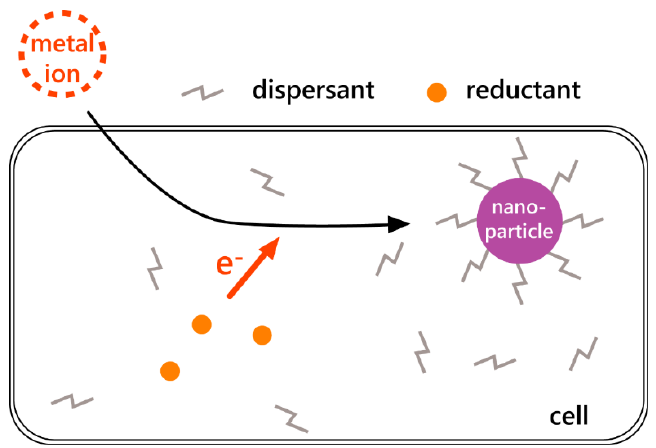
Figure 3. Model of metal nanoparticle synthesis inside cells. Metal ions are reduced by redox enzymes in the cytoplasm. The metabolites inside the cells surround the surface of NPs and behave as dispersants.